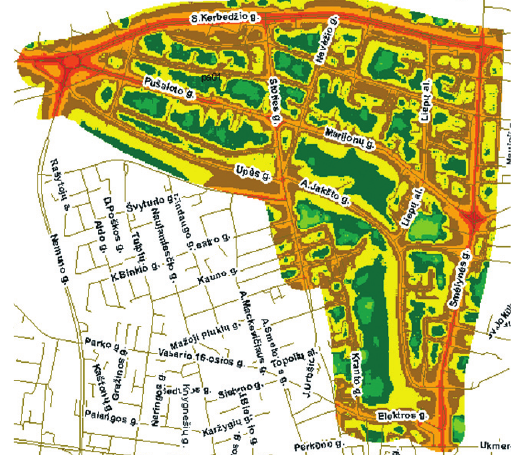
Fig. 8. Modelled noise level of segment 2 of the central part of Panevėžys city in the day-time